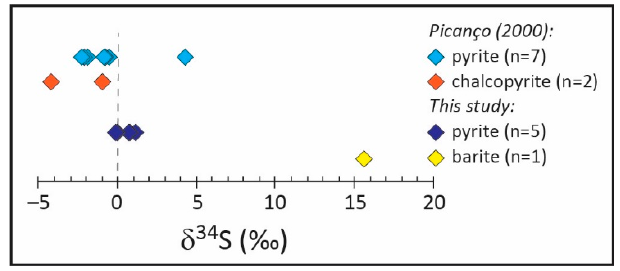
Figure 14. δ 34 S isotopic composition of pyrite, chalcopyrite, and barite from the Passa Três deposit, data from this study and Picanço [16].